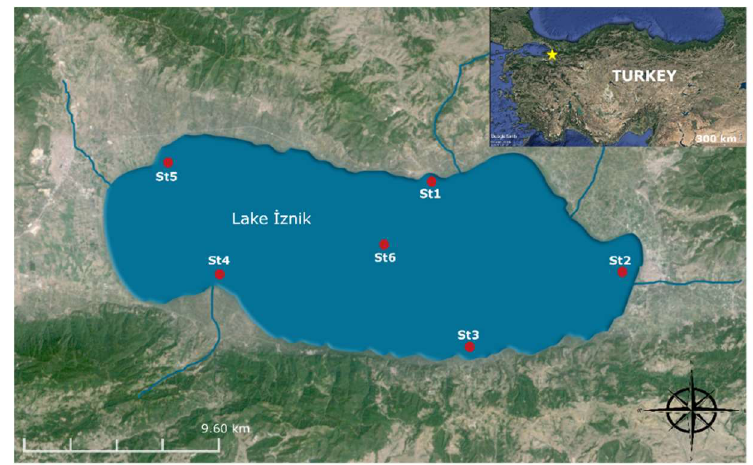
Figure 1. Sampling sites of Lake İznik.